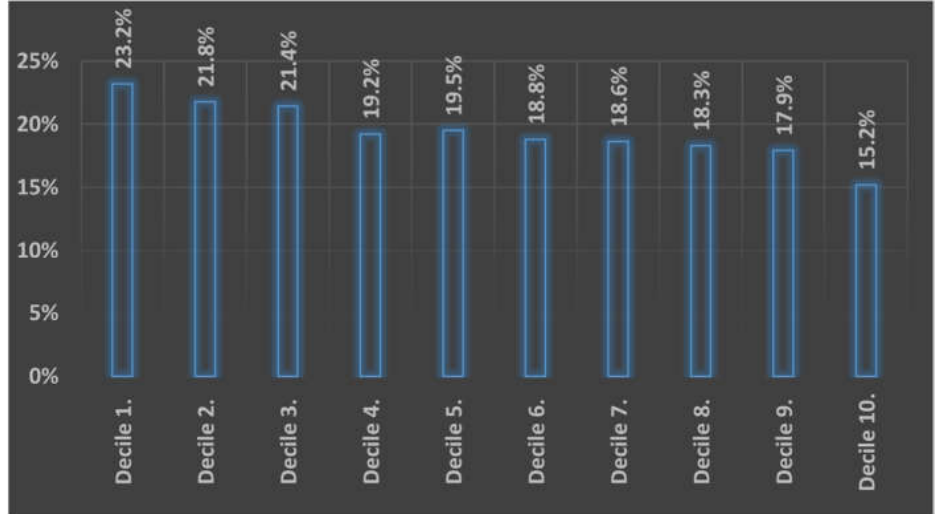
Figure 1. Share of annual household maintenance and household energy expenditure per capita in income deciles, in 2019 (%). Source: Compiled by authors based on CSO data [36].